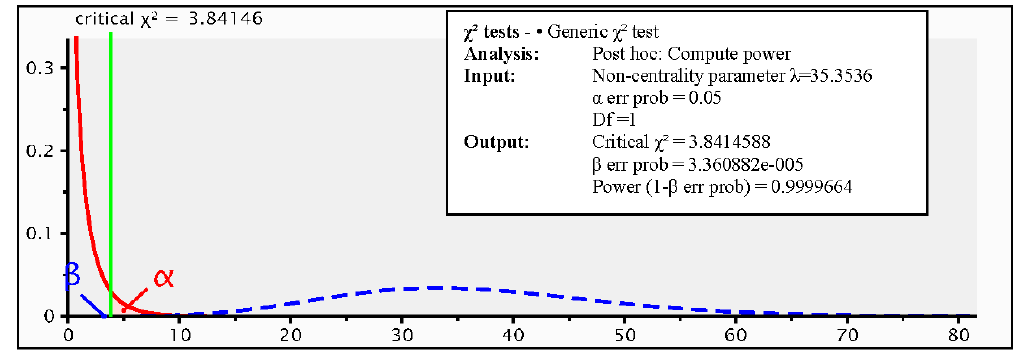
Figure 12. Power analysis (Source: G* Power output [55]).